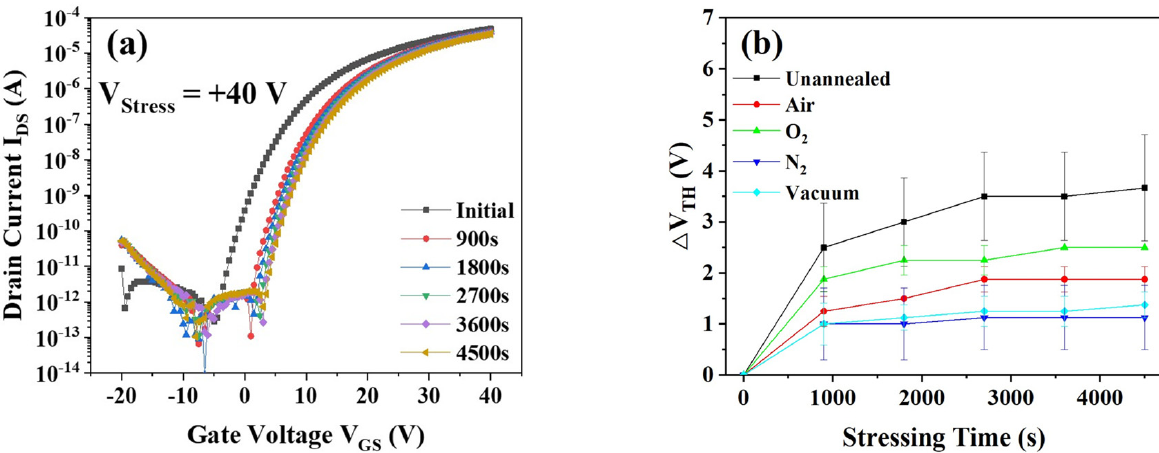
Figure 3. ( a ) Stressing time dependence of the transfer curves of the unannealed a-IGZO TFTs with SiO x passivation layers; ( b ) threshold voltage shifts of the a-IGZO TFTs with SiO x passivation layers annealed under different atmospheres during PBS tests.